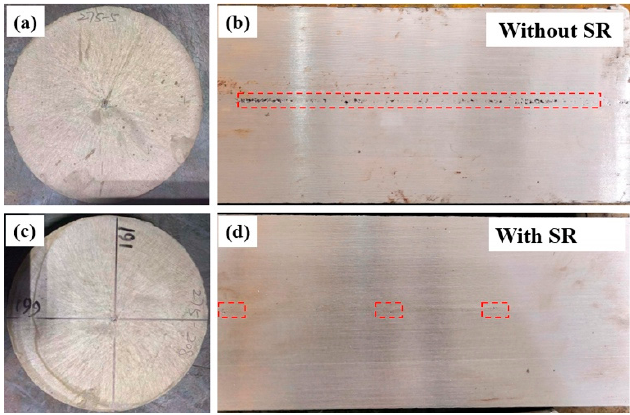
Figure 12. Macrographs of round bloom: ( a , b ) are the transverse and longitudinal sections without SR, ( c , d ) are the transverse and longitudinal sections with